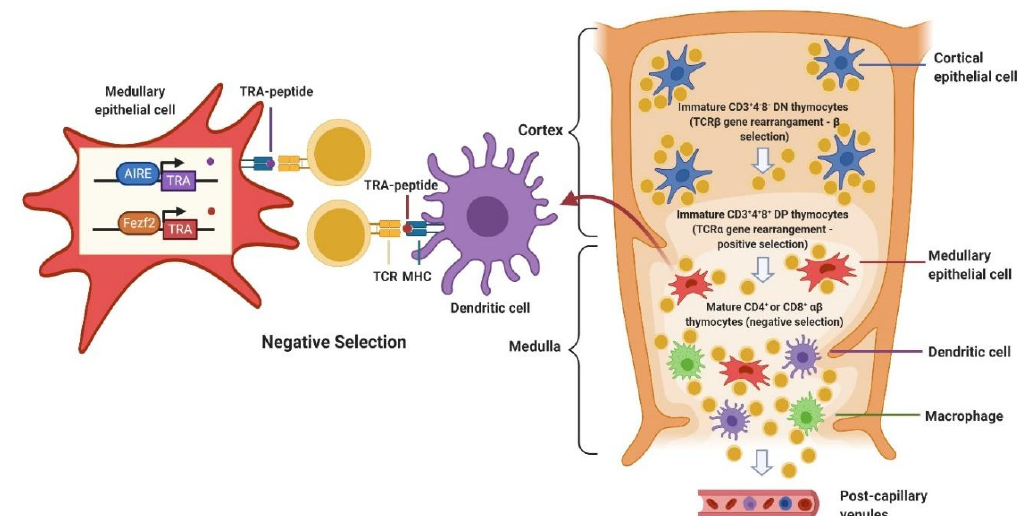
Figure 1. T-cell development process. DN: double negative; DP: double positive; MHC: major histocompatibility complex; TCR: T-cell receptor; AIRE: Auto Immune Regulator; TRA; tissue-restricted antigen; Fezf2: forebrain embryonic zinc finger-like protein 2.